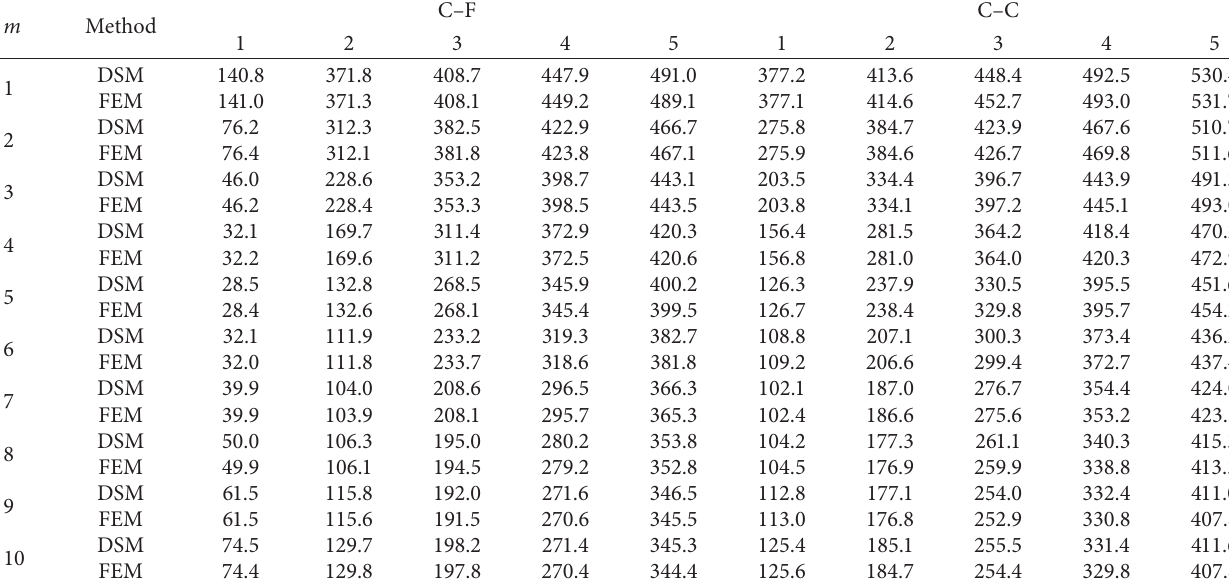
Table 2: Frequencies of the conical shell under C–F and C–C boundary conditions